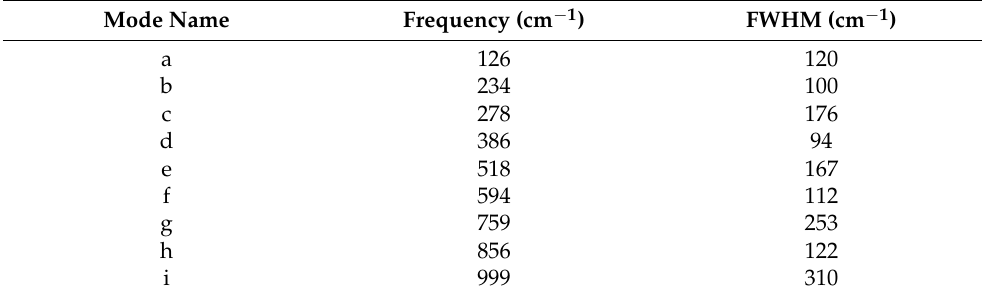
Table 4. Notations, frequencies and line widths of Raman spectra of NBT05Fe ceramics at room